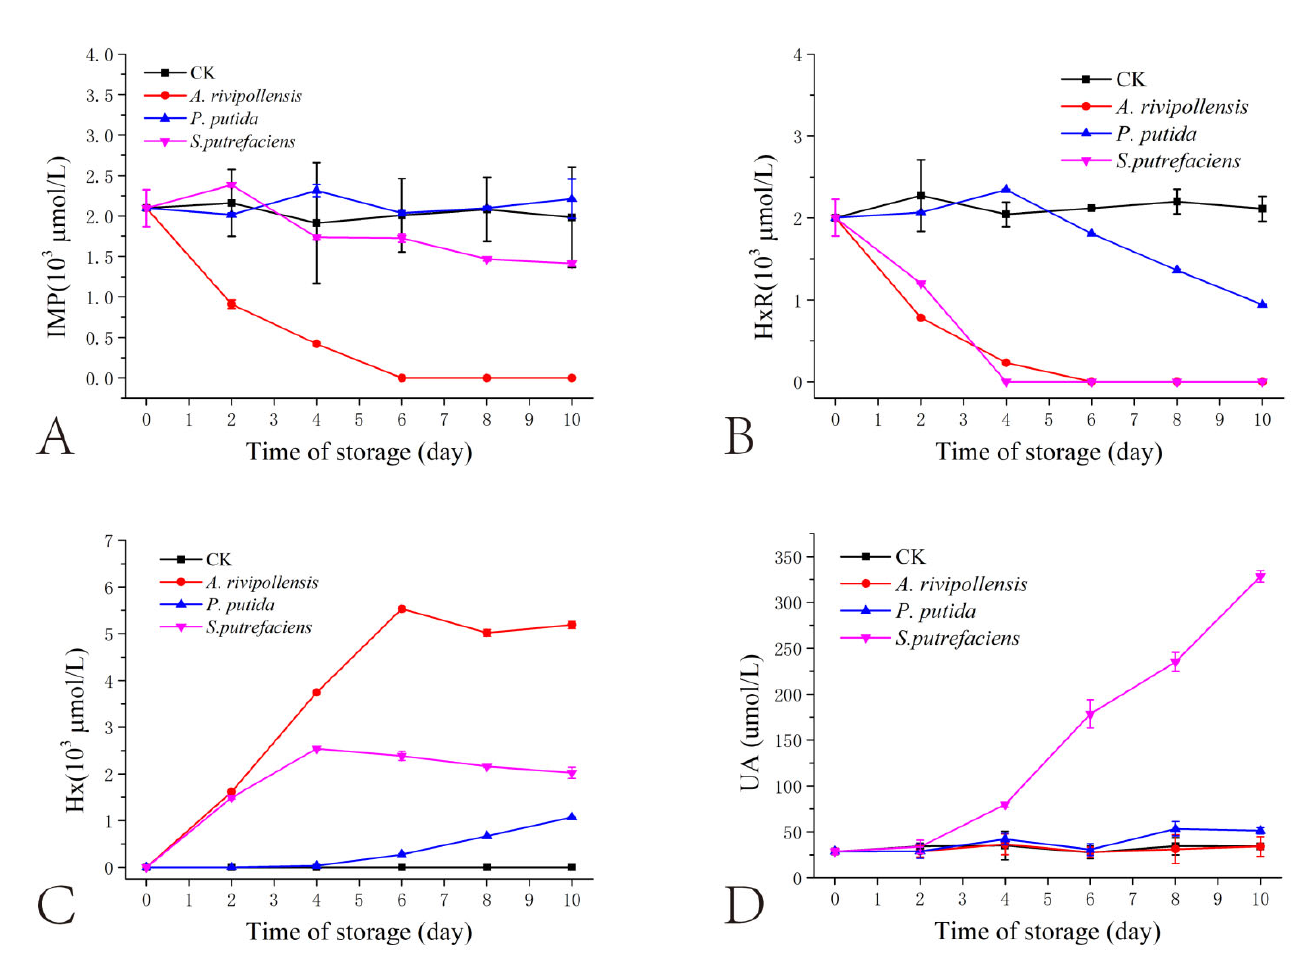
Figure 4. Changes in IMP ‐ related compounds contents of grass carp juice inoculated with different spoilage bacteria during 4 °C storage. ( A ) Inosine monophosphate (IMP); ( B ) Hypoxanthine ribonucleoside (HxR); ( C ) Hypoxanthine (Hx); ( D ) Uric acid (Ua).CK: Not inoculated.